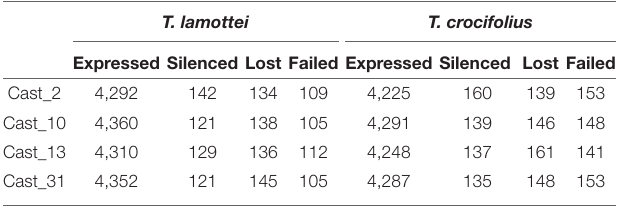
TABLE 3 | Expression states of homoeologs derived from T. lamottei or T. crocifolius .